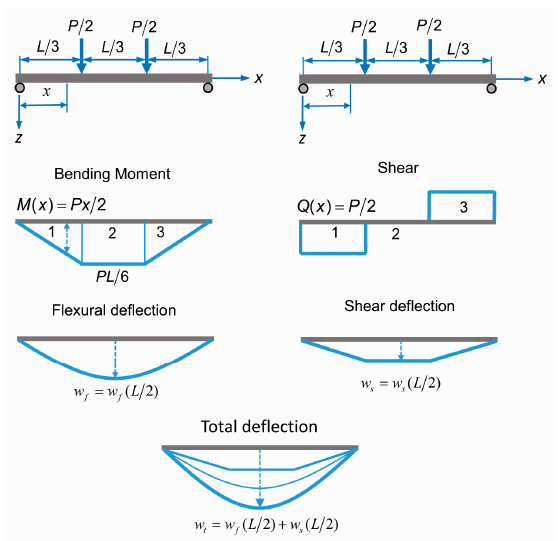
Figure 7. The procedure to obtain the load-total deflection in a four-point beading test.